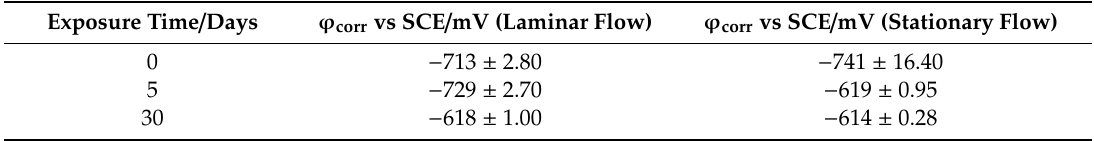
Figure 4. Free corrosion potential ( ϕ corr ) values of AA6061-T6 samples in Caribbean seawater during 30 days: ( a ) with laminar and ( b ) stationary flows. Table 4. Average of free corrosion potential ( ϕ corr ) values for AA6061-T6 in Caribbean seawater under laminar and stationary flows at different times.